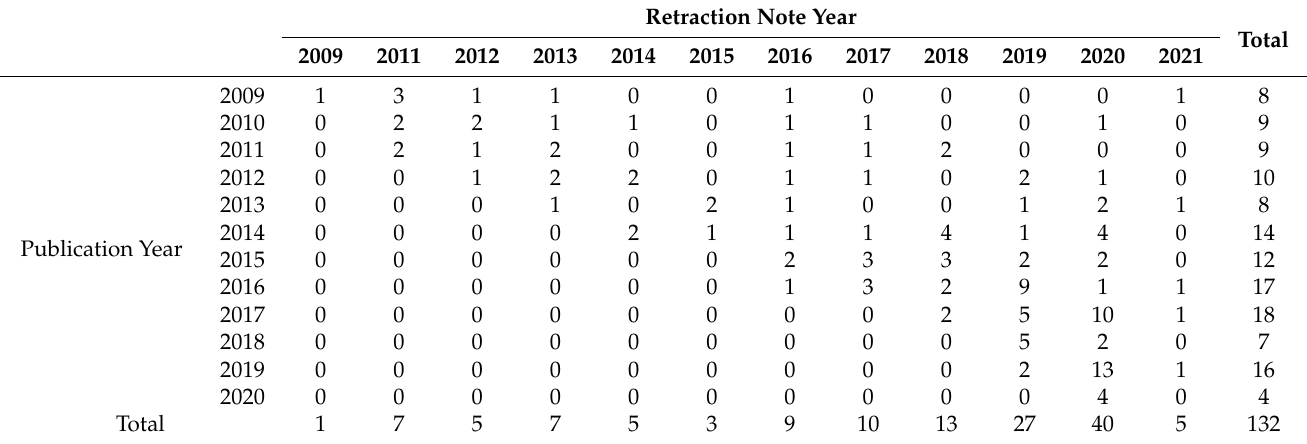
Table 8. Springer Nature image retractions.